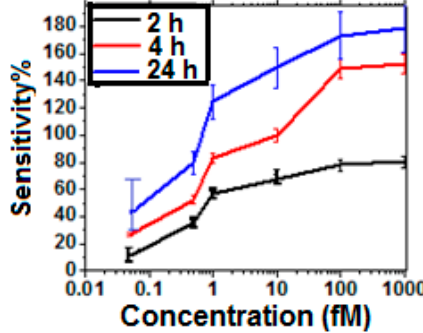
Figure 8. Variation of sensitivity with increasing concentration of Hep-B virus for different incubation times and 25% glutaraldehyde concentration.